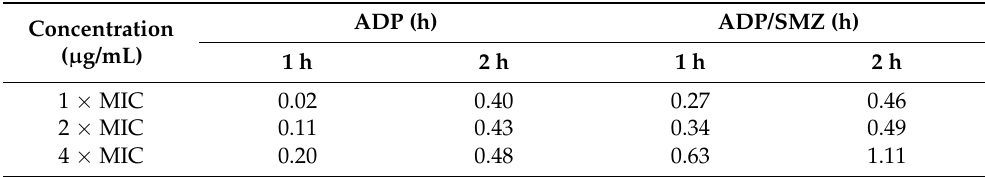
Table 3. The PAE of ADP and ADP/SMZ against G. parasuis H78.